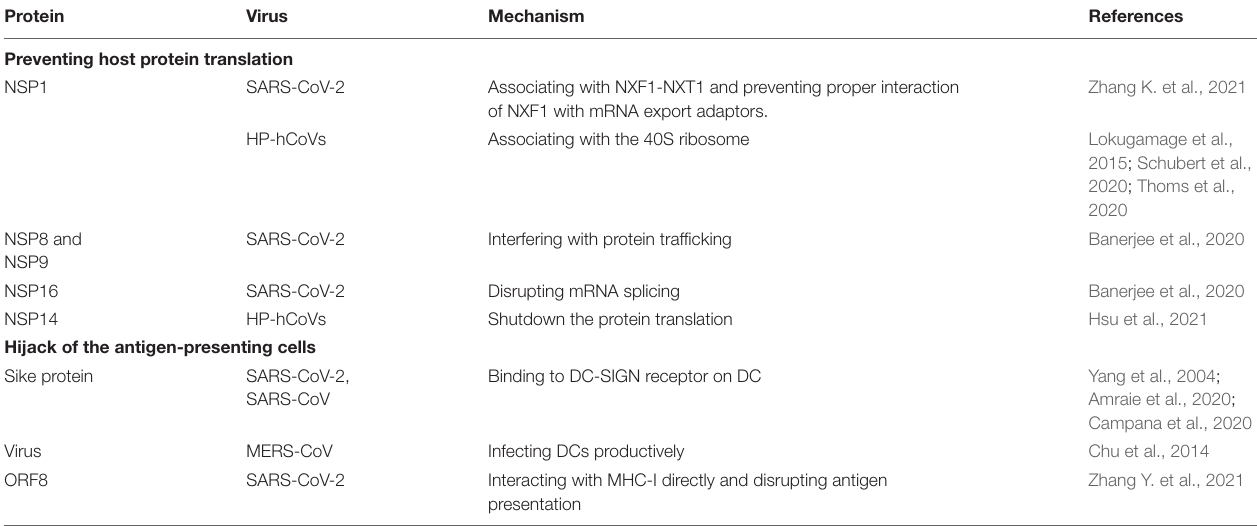
TABLE 3 | Other innate immune evasion strategies employed by HP-hCoVs.